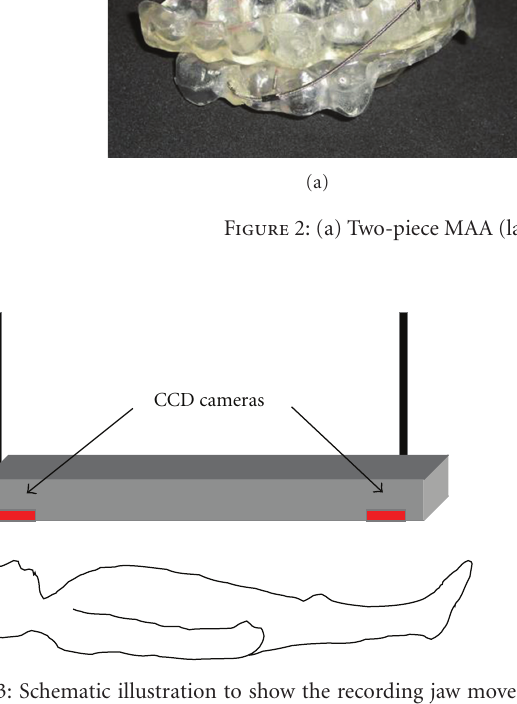
Figure 3: Schematic illustration to show the recording jaw move- ment by means of Gnathohexagraph.